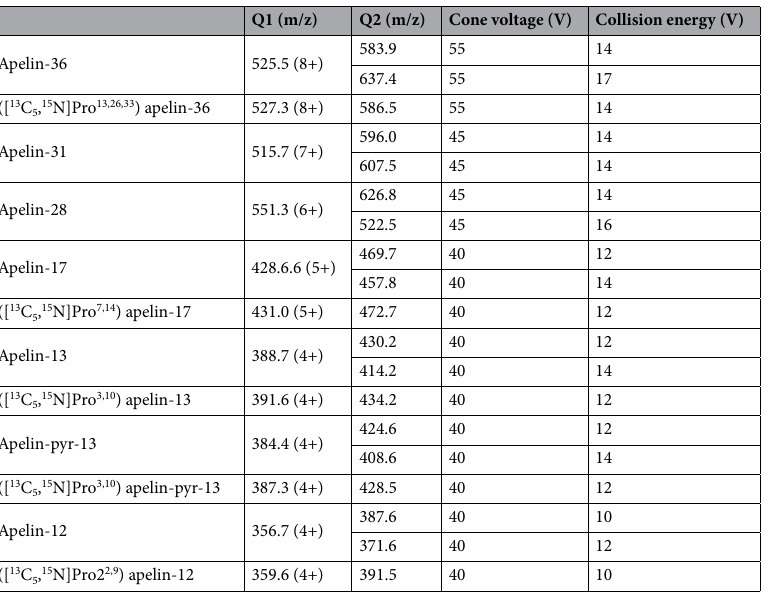
Table 2. MRM transition and mass spectrometer